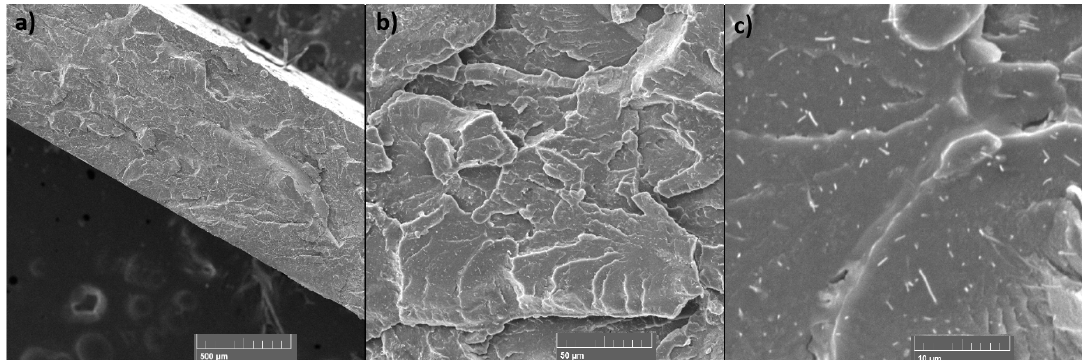
Figure 13. SEM micrographs of the fracture surface for the PET-G 6T 0.5C sample at ( a ) 100×, ( b ) 1000× and ( c ) 2000× magnification.